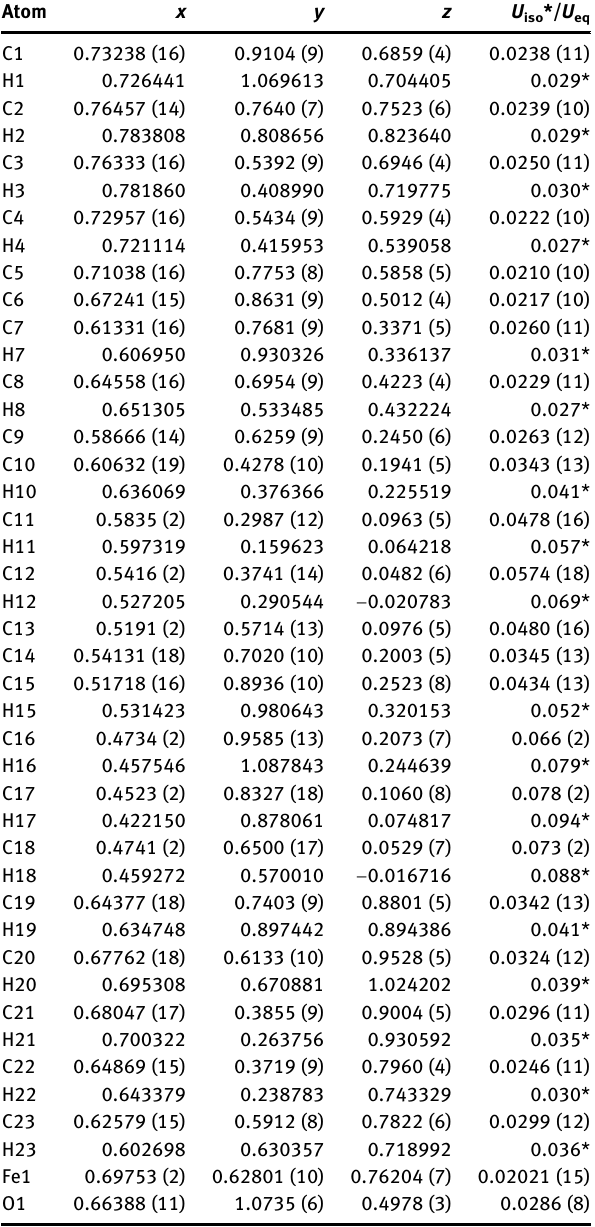
Table  : Fractional atomic coordinates and isotropic or equivalent isotropic displacement parameters (Å 